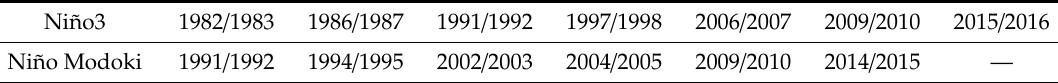
Table 1. El Niño3 and El Niño Modoki years over the period (1979–2016) following the same criterion as in Tedeschi et al., [15] (see text for details). Gray shaded boxes were common years. The year 1982 / 1983 means December 1982 and January-February 1983.